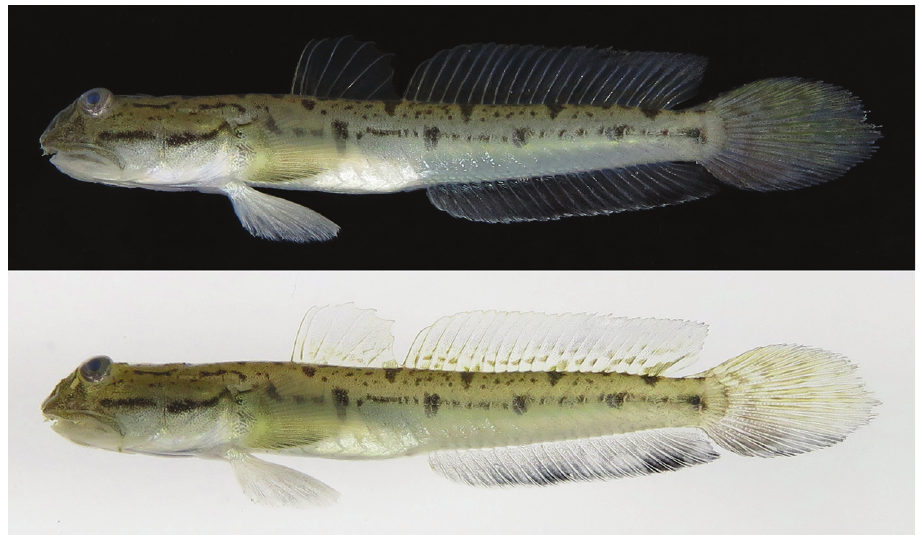
Figure 1. Lateral view of a fresh specimen of Apocryptodon punctatus , KPM-NI 40559, 35.6 mm SL, collected from a mudflat estuary of Kushima City, Miyazaki Prefecture, Kyushu, Southern Japan. Top, photo number KPM-NR 166540B; bottom, photo number KPM-NR